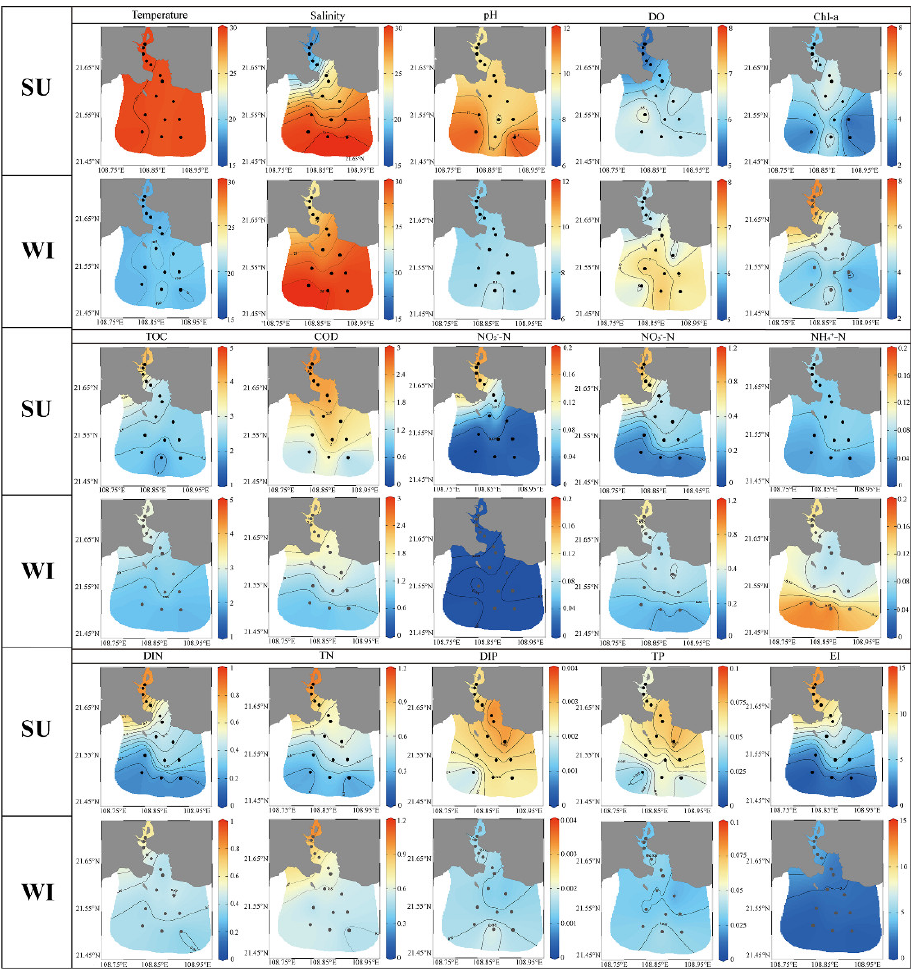
Figure 2. Environmental factors in summer and winter in the Dafengjiang River estuary. SU, summer; WI, winter. The environmental parameters in summer and winter (mean with SD) are provided in Supplementary Table S1.